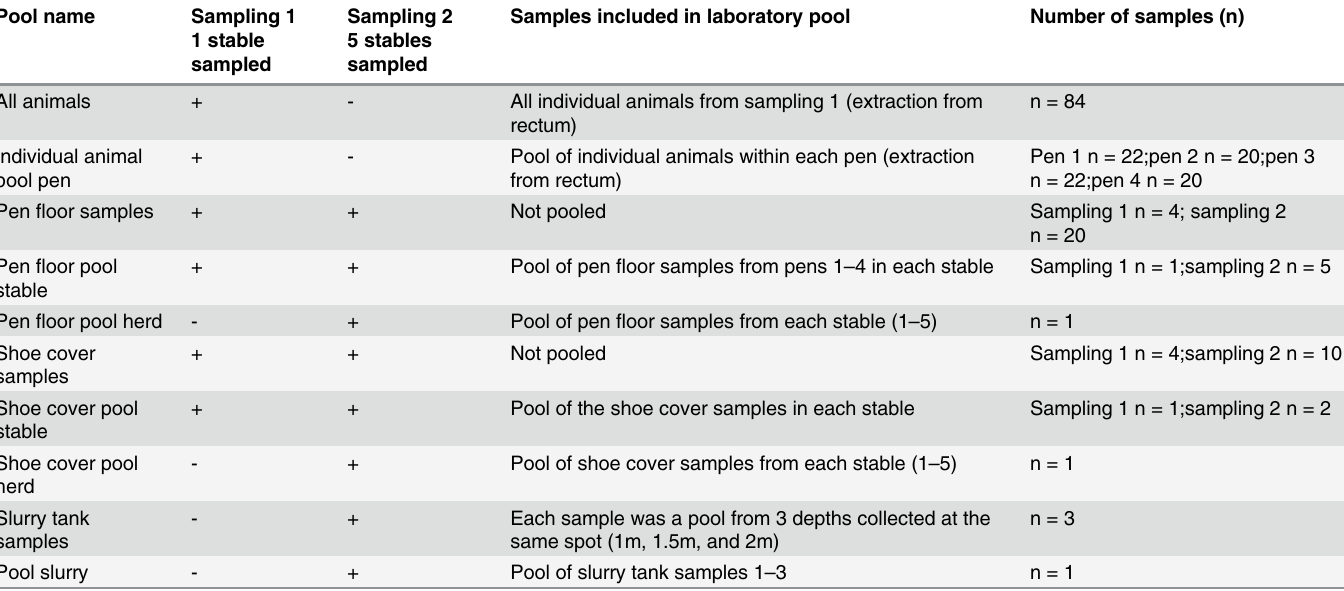
Table 1. Overview of the samples collected during sampling 1 and sampling 2 including different sampling methods and corresponding laboratory pools at stable and herd